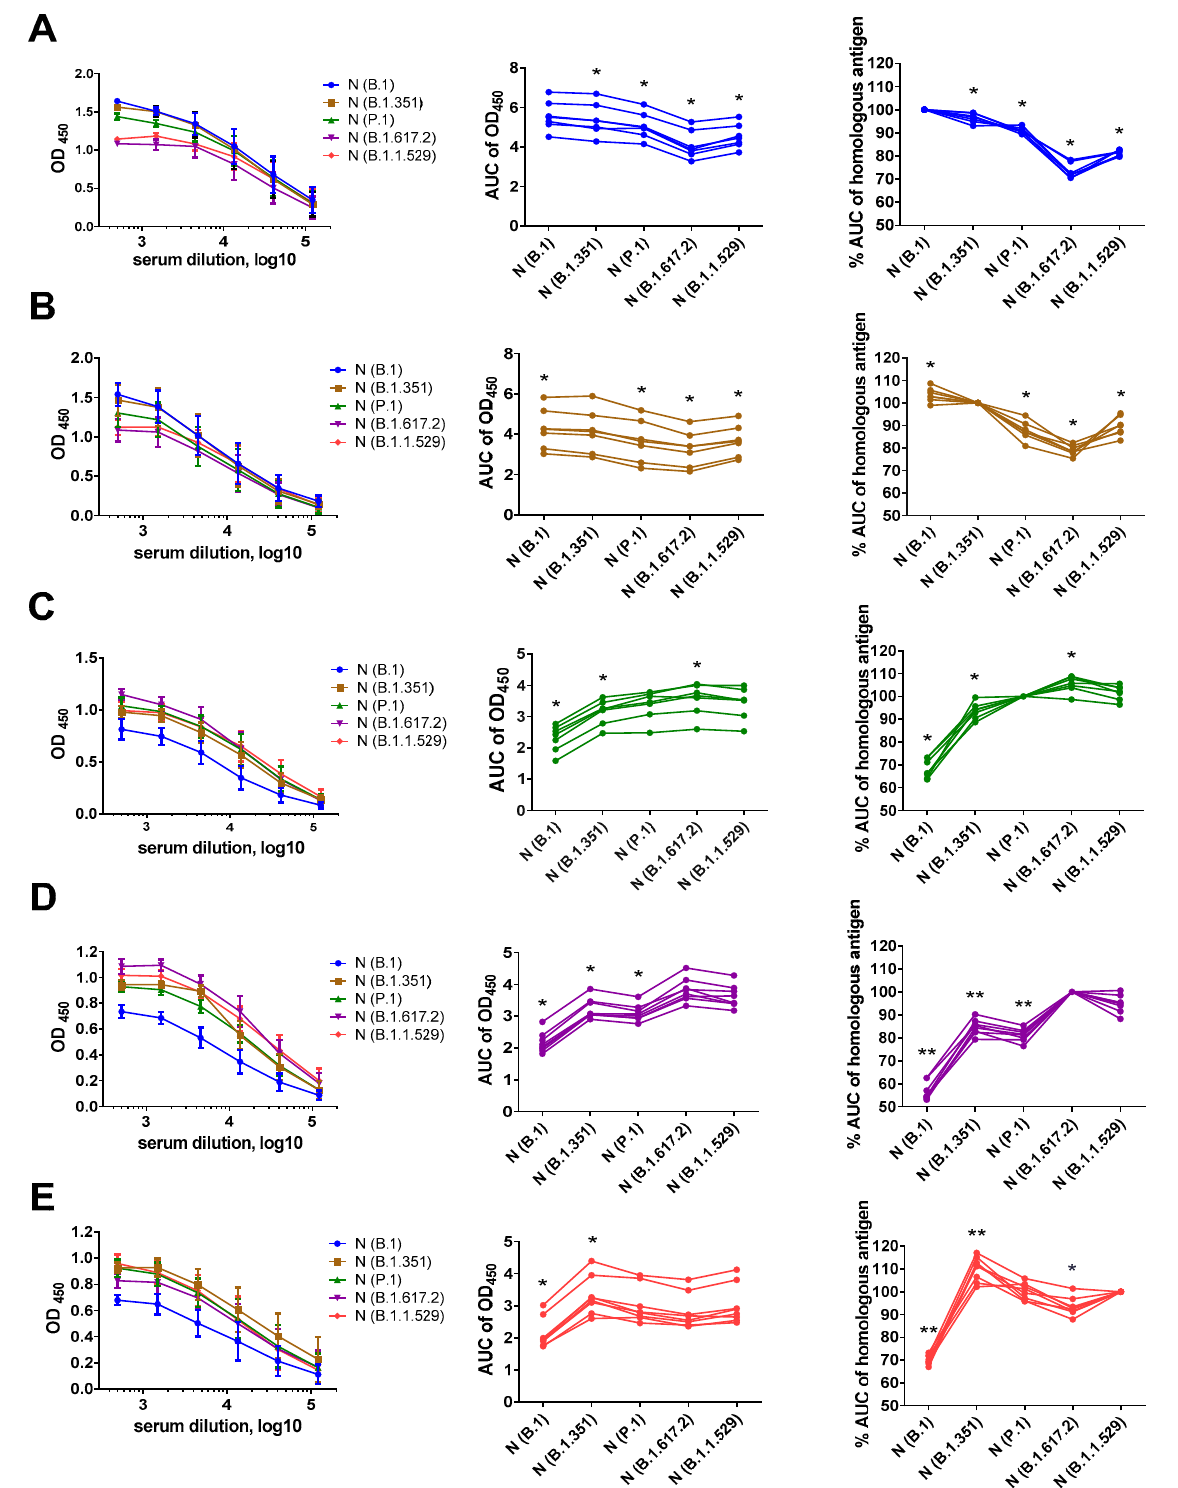
Figure 2. N-based ELISAs of serum samples of mice immunized with B.1 ( A , blue), B.1.351 ( B , brown), P.1 ( C , green), B.1.617.2 ( D , magenta) and B.1.1.529 ( E , red). The left panel shows the mean OD 450 values in ELISAs with the indicated N antigen. The area under the OD 450 curve (AUC) values for each serum sample tested against five N antigens are shown in the middle panel. The right panel shows the AUC values normalized to the homologous antigen. These data were compared using the Wilcoxon matched-pairs test. * p < 0.05, ** p < 0.01.